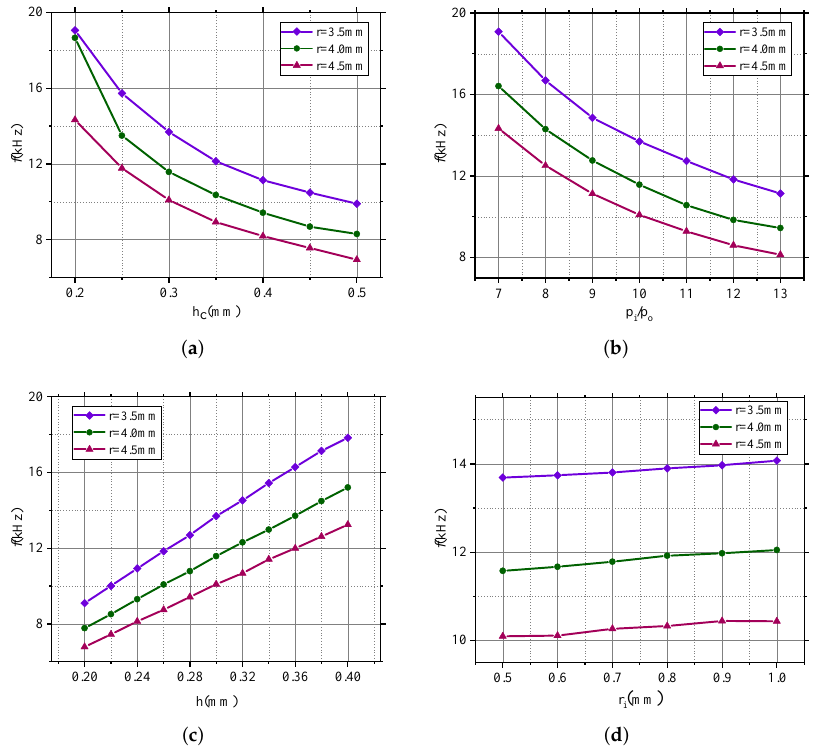
Figure 6. Resonant frequencies ( n = 2) of microhemispherical shells with different parameters. ( a ) Influence of groove depth on resonant frequency. ( b ) Influence of pressure ratio inside and outside the groove on resonant frequency. ( c ) Influence of fused silica thickness on resonant frequency. ( d ) Influence of groove inner diameter on resonance